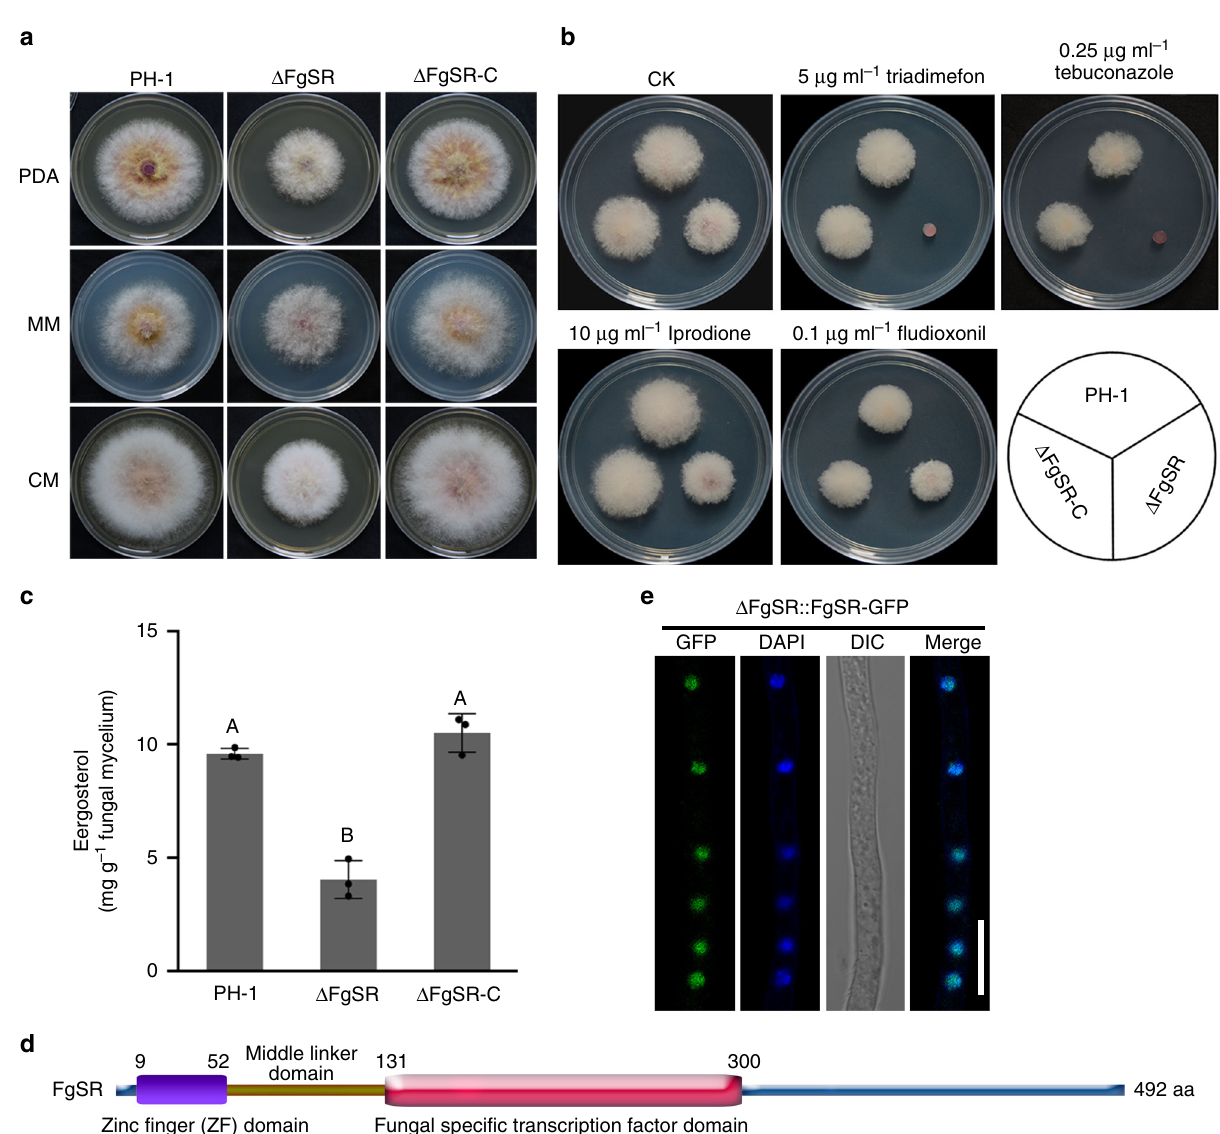
Fig. 1 Transcription factor FgSR regulates ergosterol biosynthesis in F. graminearum . a Comparisons in colony morphology among the wild-type PH-1, Δ FgSR and the complemented transformant Δ FgSR-C grown on PDA, CM, or MM. b Δ FgSR displayed increased sensitivity to azole compounds but not to the compounds targeting the high osmolarity glycerol (HOG) pathway. A 5-mm mycelial plug of each strain was inoculated on PDA alone or supplemented with 5 μ g ml – 1 tridiamenfon, 0.25 μ g ml – 1 tebuconazole, 10 μ g ml – 1 iprodione or 0.1 μ g ml – 1 fl udioxonil, and then incubated at 25 °C for 2 days. c Relative abundance of ergosterol in each strain after growth in YEPD for 36 h. Data presented are the mean ± s.d. ( n = 3). Bars followed by the same letter are not signi fi cantly different according to a Fisher ’ s least signi fi cant difference (LSD) at P = 0.01. d The FgSR amino acid sequence shows a typical Zn(II)2-Cys6 zinc fi nger domain and a fungal speci fi c transcription factor domain identi fi ed using the SMART protein database (http://smart.embl-heidelberg.de) and the NBCI protein database (https://blast.ncbi.nlm.nih.gov/Blast.cgi). e FgSR-GFP localized to the nucleus. Bar = 10 μ